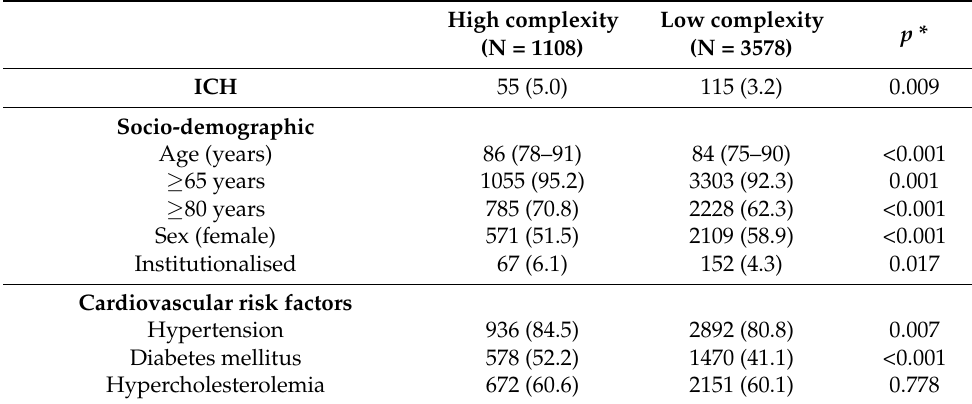
Table 3. Baseline characteristics of GMA-4 population according to complexity